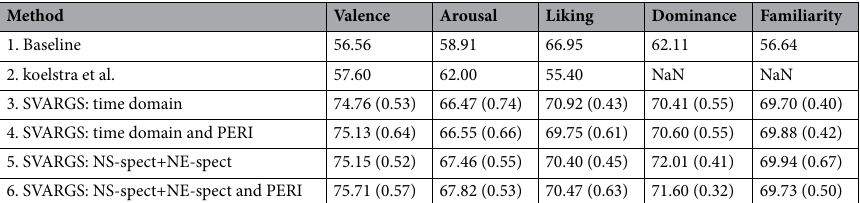
Table 3. Binary cross-validated classification accuracy on DEAP data set. The first row merely lists the proportions of the majority class for each emotion and sets the baseline accuracy. The second row shows, for each emotion, the cross-validated accuracy obtained by Koelstra et al. 49 . The third row shows the accuracies obtained using all the time-domain features obtained from our SVARGS method listed in section “DEAP features via SVARGS and CGC ”. The fourth row is the same as the third except with the addition of the peripheral features. The fifth row shows the accuracy obtained with the SVARGS network scalar (NS-spect) and network edge band spectral features (NE-spect) and the last row shows the accuracy with NS-spect, NE-spect and the peripheral features. The feature group abbreviations are listed in section “DEAP features via SVARGS and CGC ”. We used the the Adaboost-SAMME algorithm for classification, with 8-fold cross- validation aggregated over 8 runs. The accuracies shown for our methods is the average over 10 such meta runs of the modal accuracy in the last 75 out of 225 rounds of adaboost-SAMME. Any standard deviations are indicated in brackets.